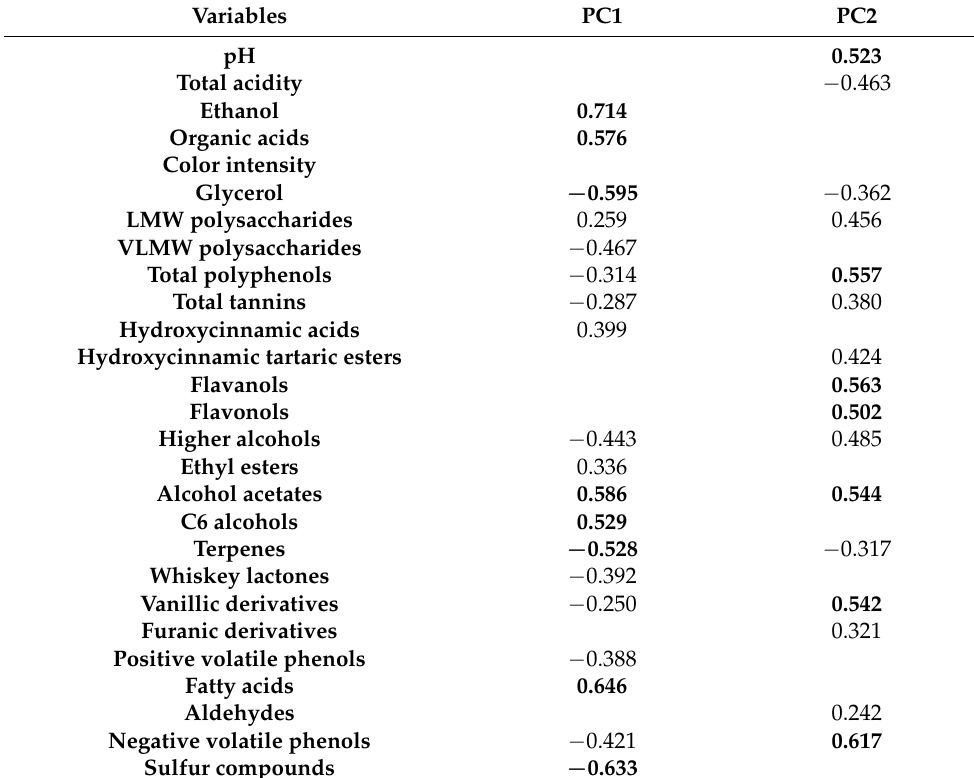
Table 4. PCA loading values of the variables selected in white wines.